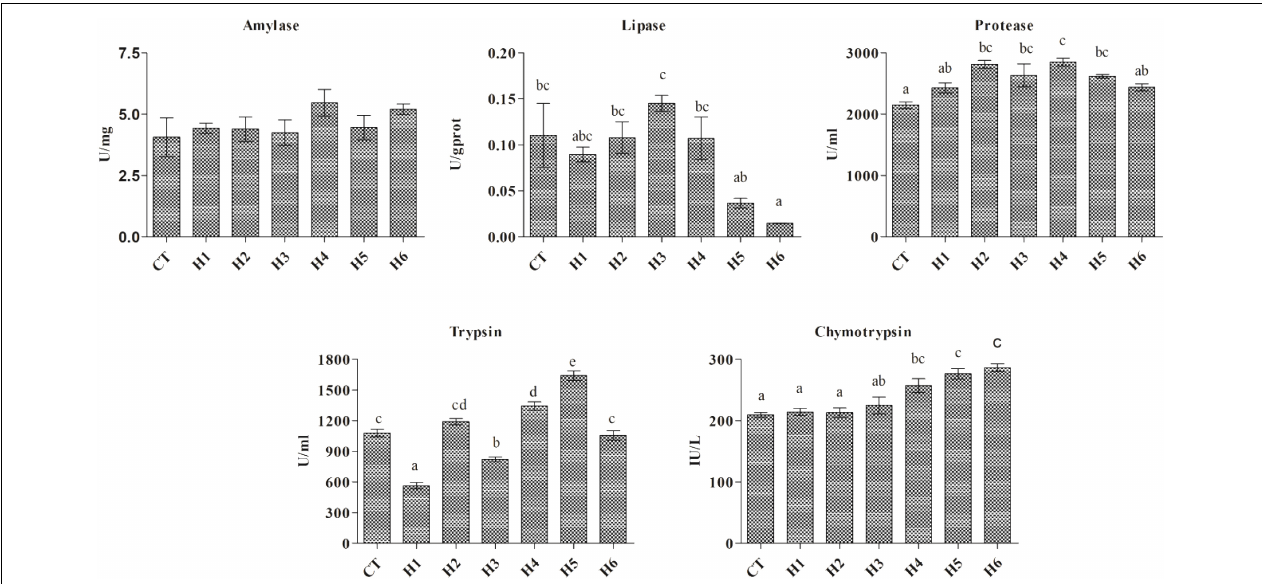
viscerosomatic index.